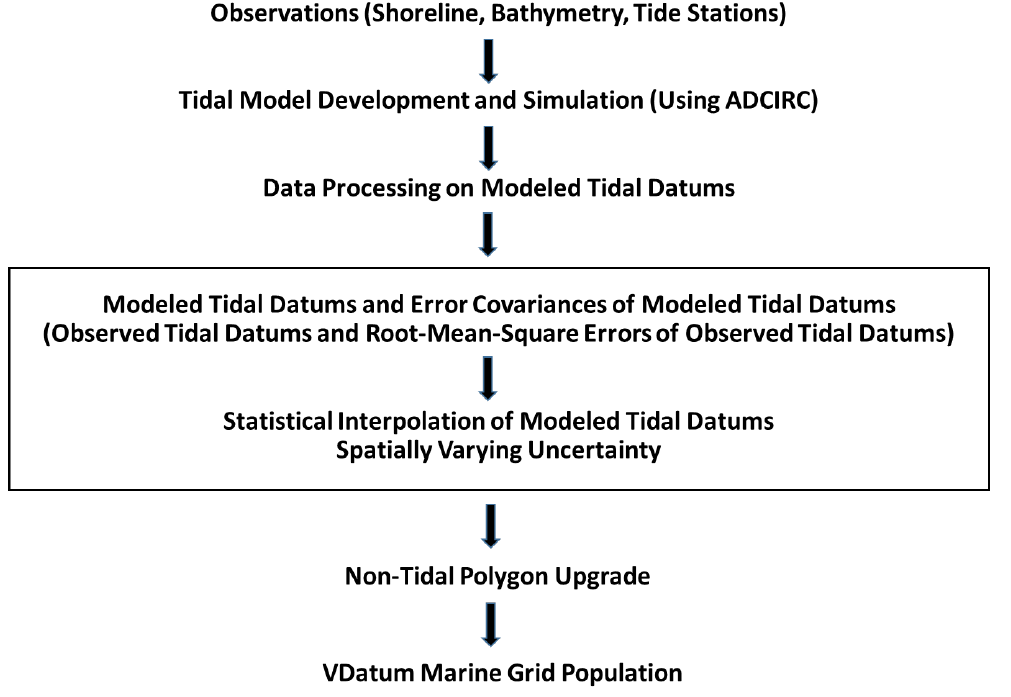
Figure 4. A schematic diagram of the workflow of the model update with the SVU statistical interpolation step enclosed within the